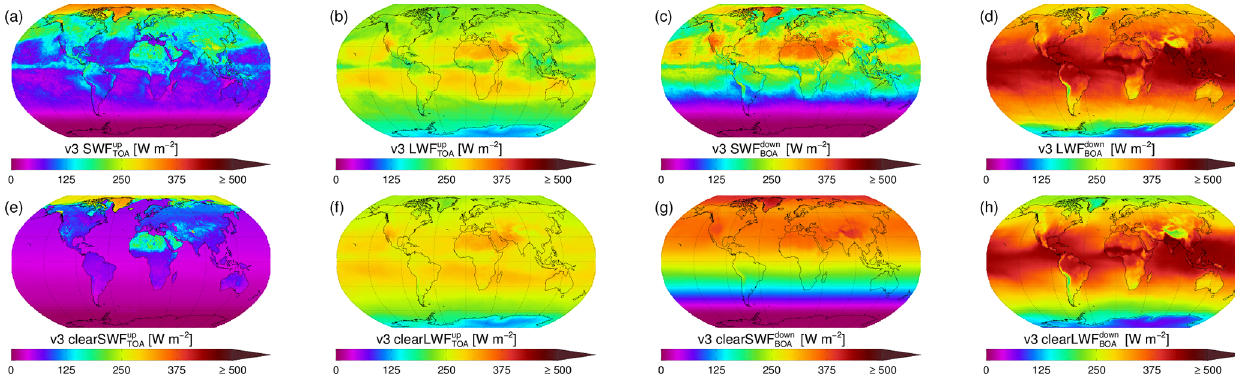
up (a–d) . , LWF up , SWF down and LWF down TOA TOA BOA BOA